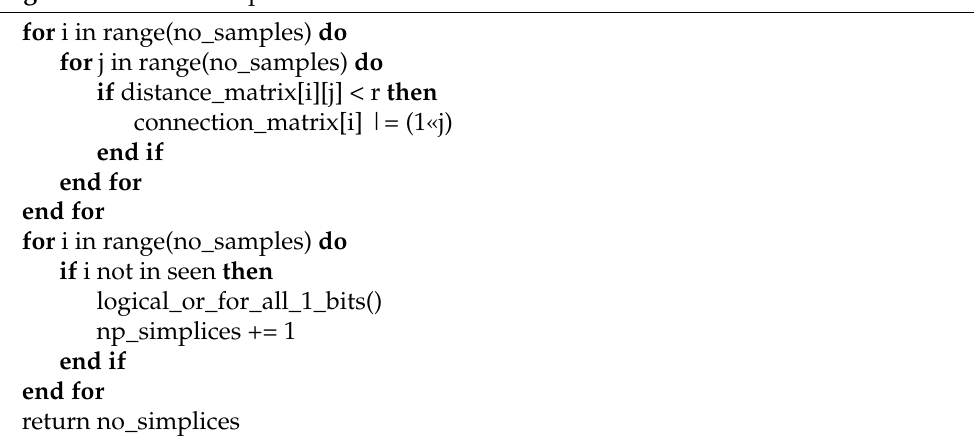
Algorithm 2 Build Simplices for distance r.